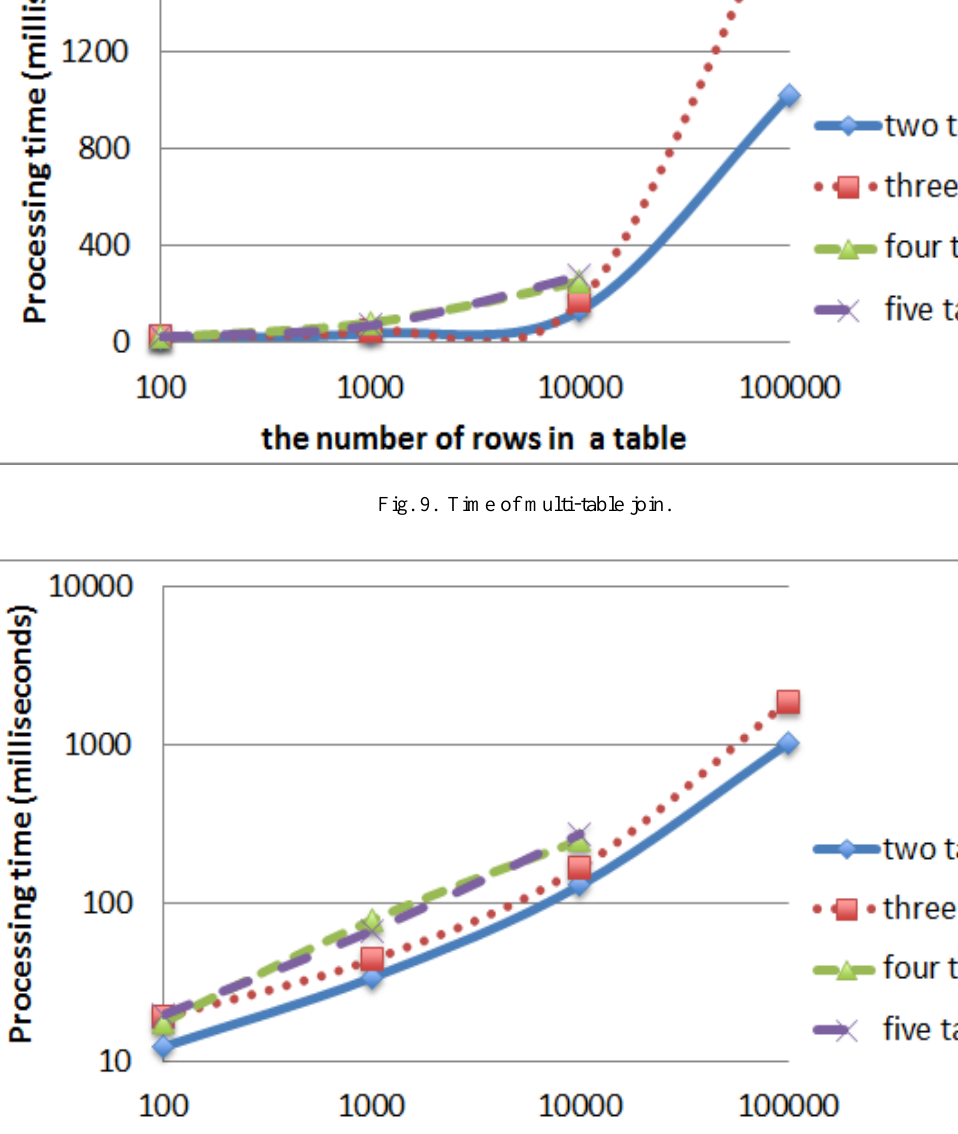
Fig. 10. Time of multi-table join (logarithmic